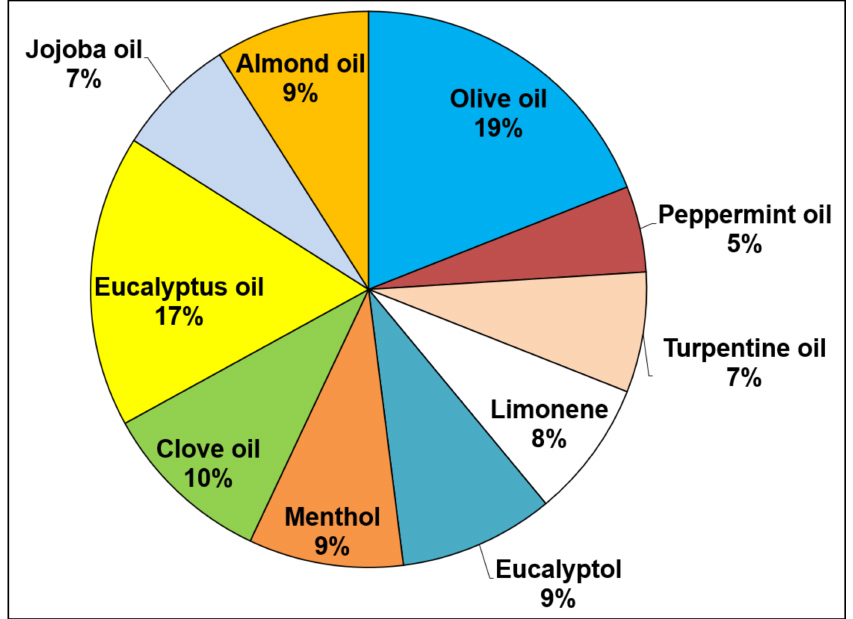
Figure 3. The most frequently used essential and carrier oils in pharmaceutical dosage formulations from all eligible articles.